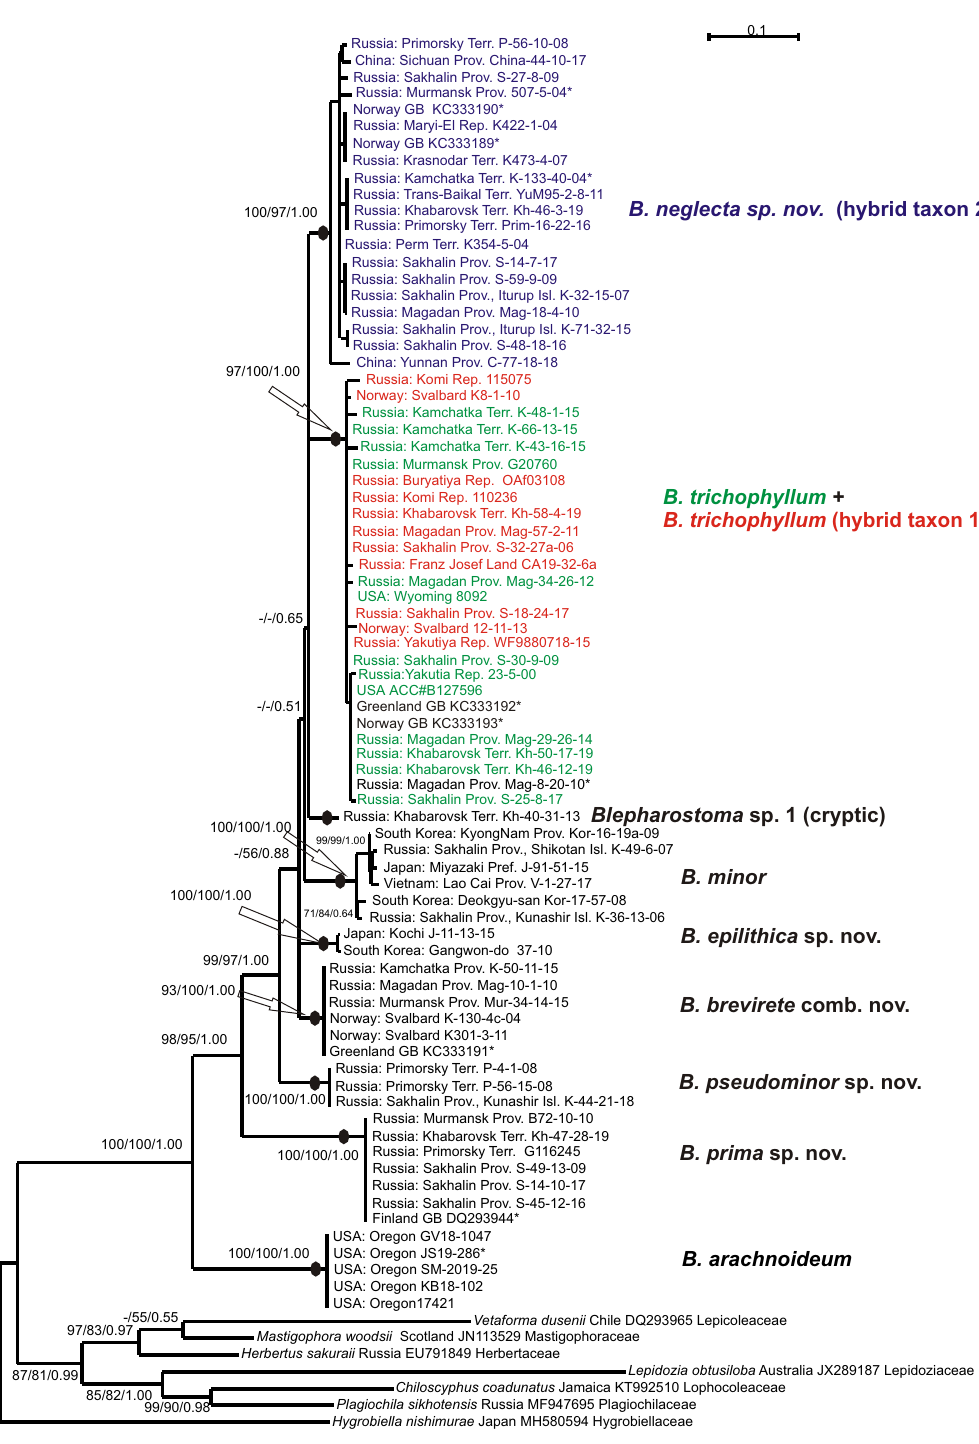
Figure 1. Phylogram obtained under the maximum likelihood criterion for the genus Blepharostoma based on the ITS1-2 nrDNA. Bootstrap support values are indicated under maximum parsimony, maximum likelihood, and Bayesian posterior probabilities of > 50%